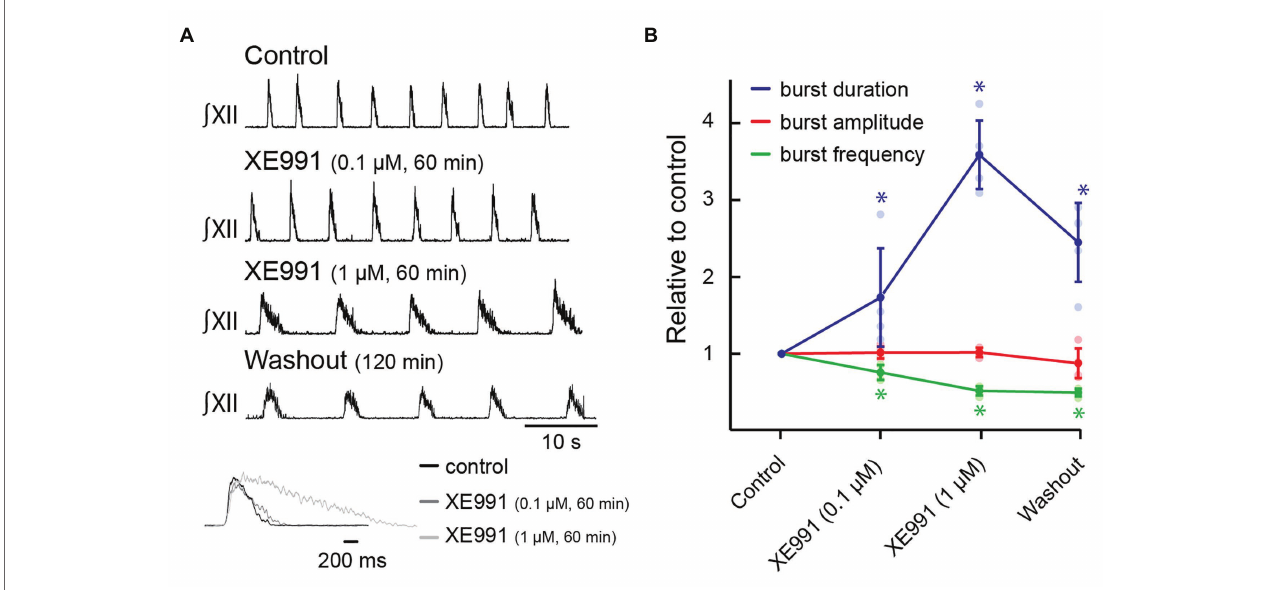
FIGURE 3 | Effects of blocking KCNQ channels with XE991 on inspiratory burst parameters in the rhythmic slice preparation. (A) Rectified, integrated recordings from XII nerve rootlets demonstrating inspiratory burst parameter changes in the presence of bath application of XE991. Inset shows an average of 10 inspiratory bursts in control (black), after 60 min of bath application of XE991 at 0.1 μ M (dark gray), and after 60 min of bath application of XE991 at 1 μ M (light gray). (B) Group data from XII nerve rootlet recordings where XE991 was applied to the bath at 0.1 and then 1 μ M, n = 5. * p < 0.05, repeated measures (RM) ANOVA with Tukey’s multiple comparisons post hoc